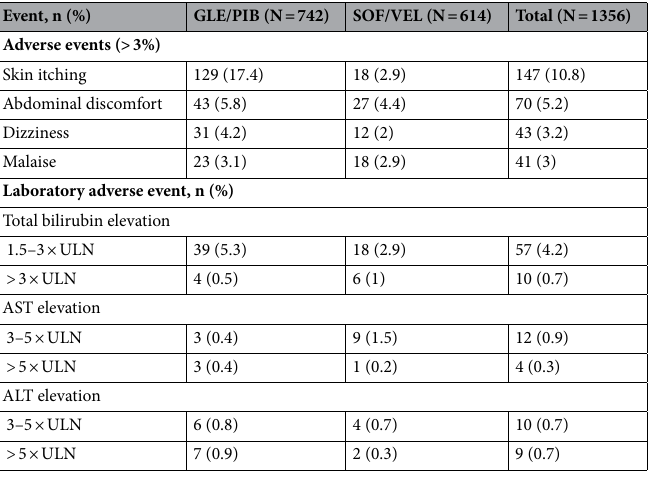
Table 4. Safety summary. ALT alanine aminotransferase; AST aspartate aminotransferase; GLE/PIB glecaprevir/pibrentasvir; SOF/VEL sofosbuvir/velpatasvir; ULN upper limit of